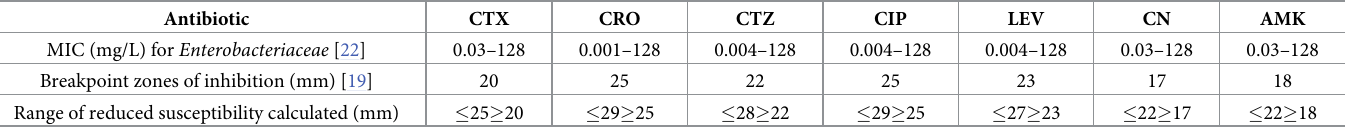
Table 2. Antibiotics used, their MIC, breakpoint zones of inhibition and range of reduced susceptibility. Antibiotic